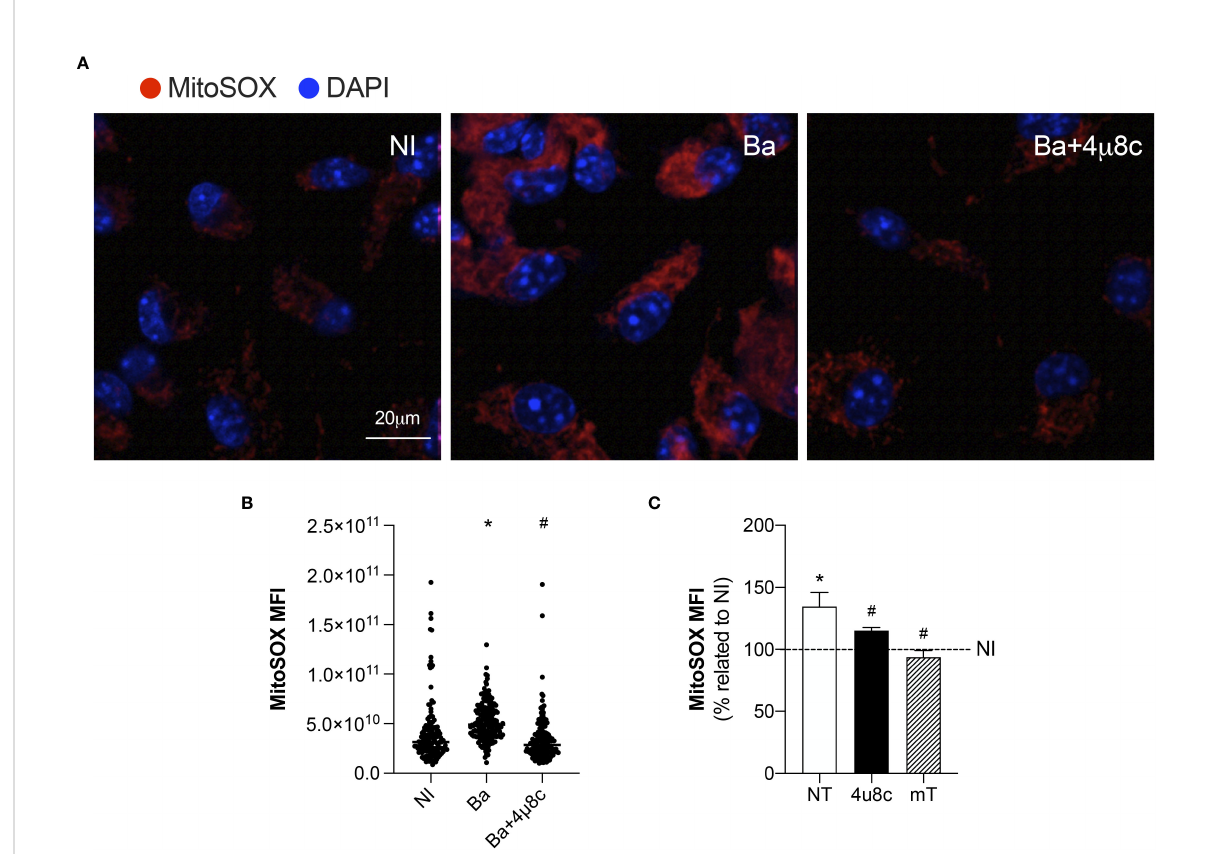
FIGURE 4 IRE1 a drives mROS generation. (A) Representative confocal microscopy of MitoSOX Red staining in macrophages from C57BL/6 mice non- infected (NI), infected with B abortus (Ba) or pre-treated with 4 m 8c (50 m M) and infected with B abortus (Ba+4 m 8c). MitoSOX Red is in red, and nuclei (DAPI) is in blue. Scale bar, 20 m m. (B) MitoSOX Red mean fl uorescent intensity, determined as described in Materials and Methods. (C) MitoSOX Red fl ow cytometry analysis of mROS production fold change induced by B abortus relativized to non-infected (NI) cells for each experimental group: non-treated (NT), pre-treated with 50 m M 4 m 8c (Ba+4 m 8c) or pre-treated with 0.5 mM Mito-TEMPO (mT). The data are representative of three independent experiments. The data (B) is presented as mean ± SD, * p < 0.05 (compared to NI) and # p <